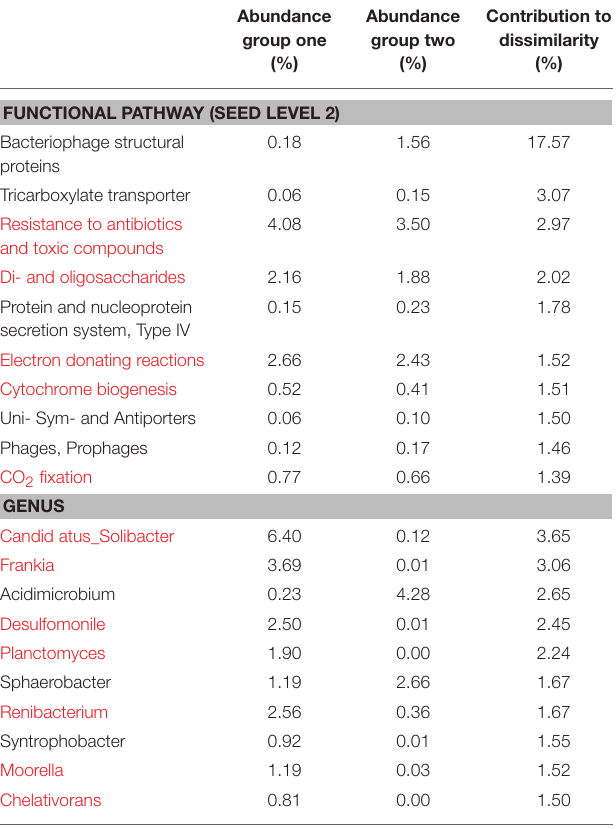
TABLE 1 | SIMilarity PERcentage (SIMPER) analysis of the 10 most significant drivers of clustering between soil